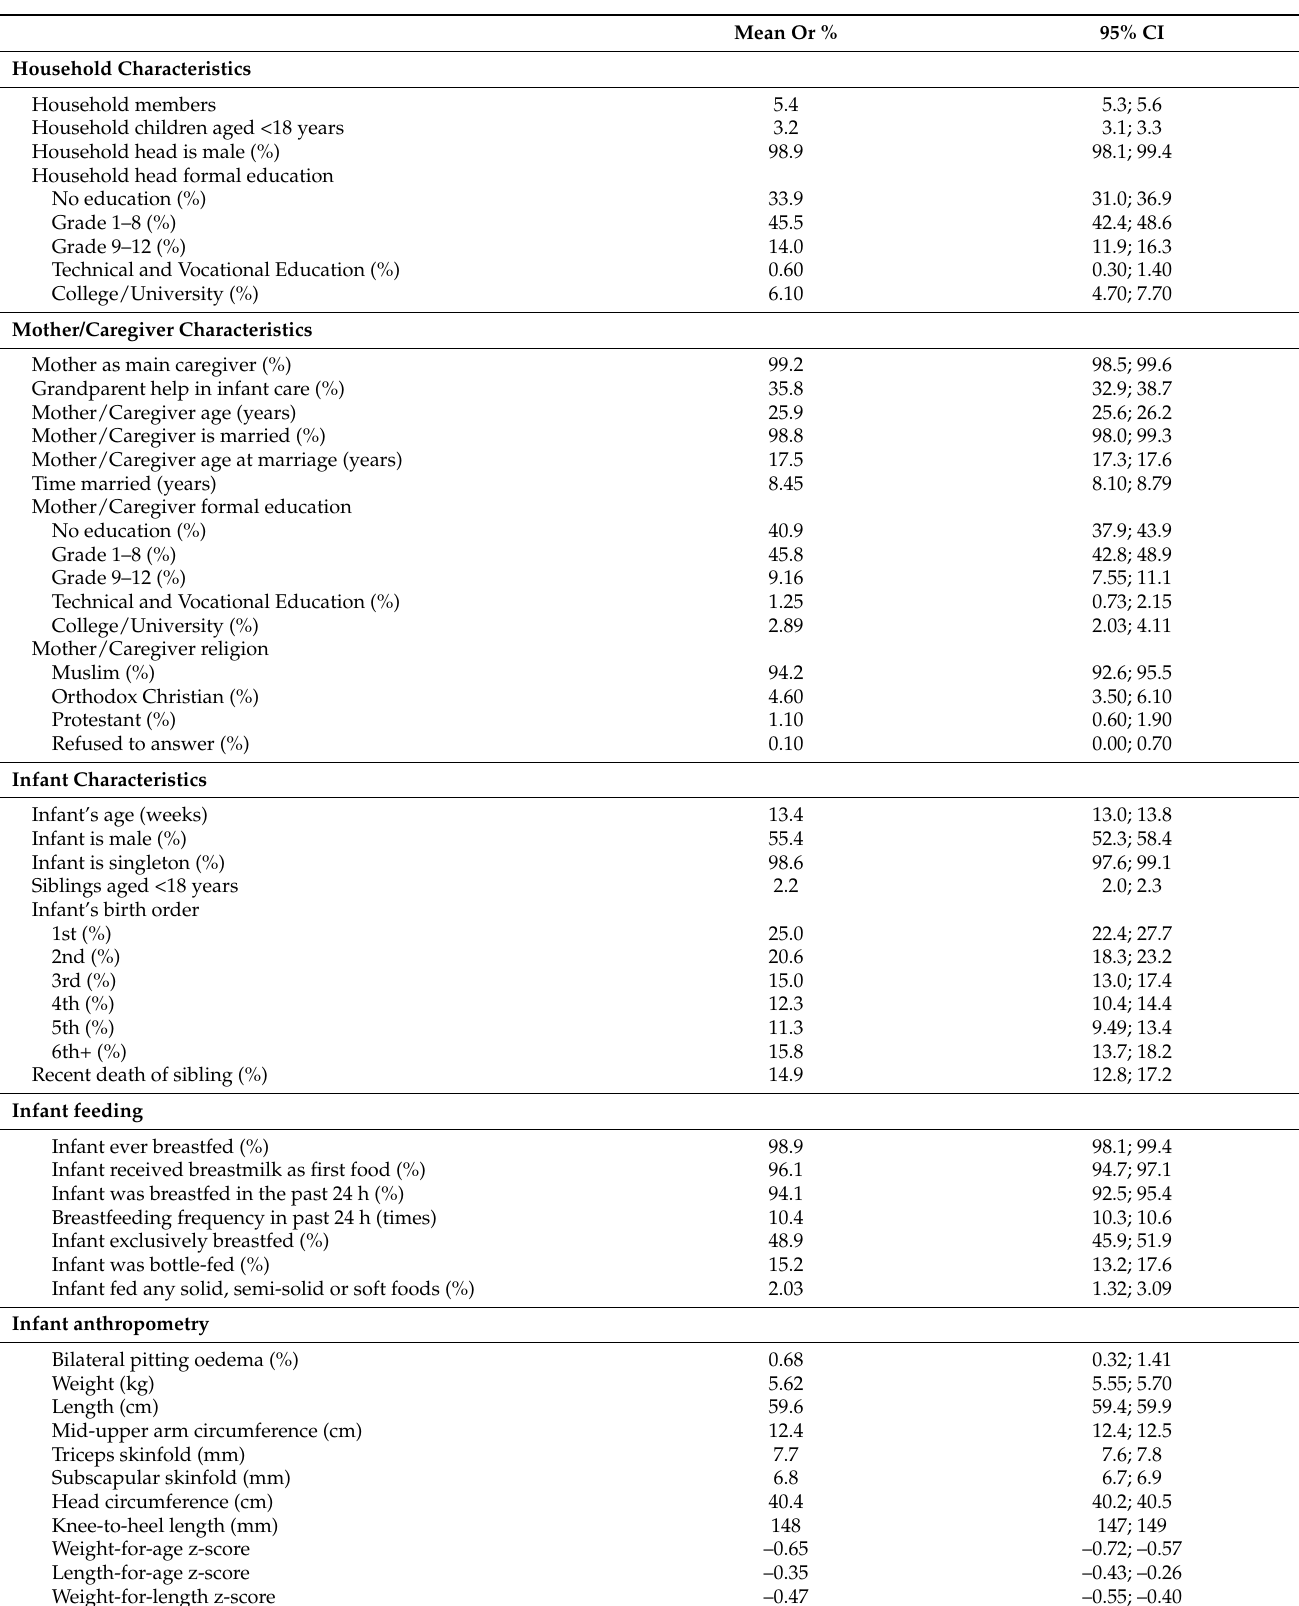
Table 1. Characteristics of the 1037 surveyed infants under six months of